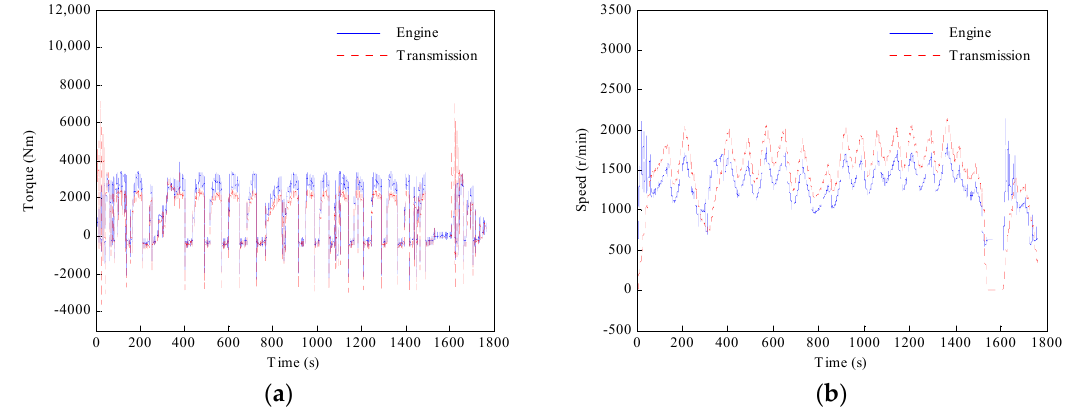
Figure 3. The proving grounds (PG) test data. ( a ) Torque signals; ( b ) rotational speed signals.